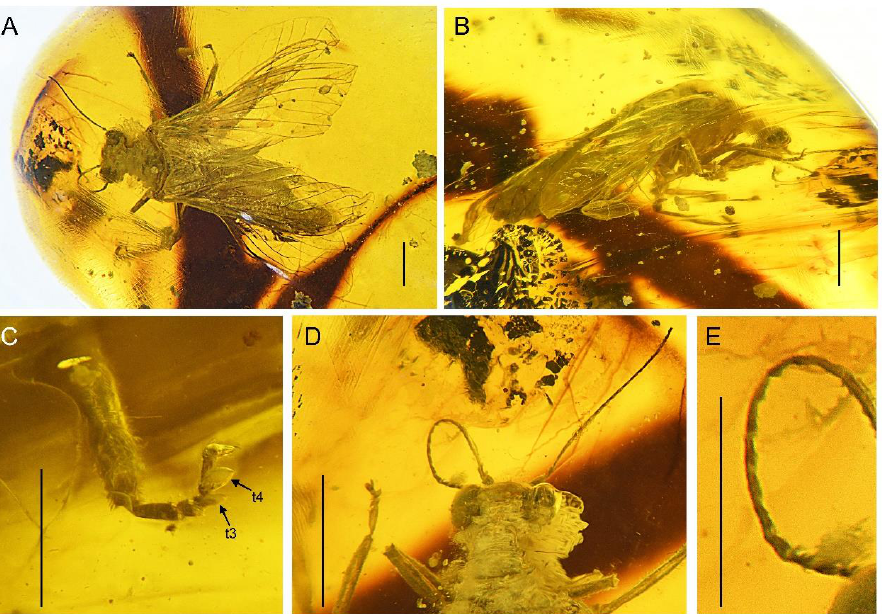
Figure 1. Paradoxoconis szirakii gen. et sp. nov. , holotype: NIGP 180659. ( A ) Habitus, dorsal view; ( B ) habitus, lateral view; ( C ) metatarsus; ( D ) head and pronotum, dorsal view; ( E ) left antenna. Abbreviation: t, tarsomere. Scale bar = 1.0 mm ( A , B , D ); 0.5 mm ( C ).